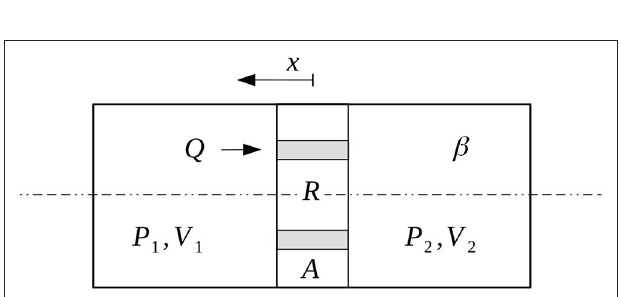
FIGURE 4 | MR damper simplified layout.